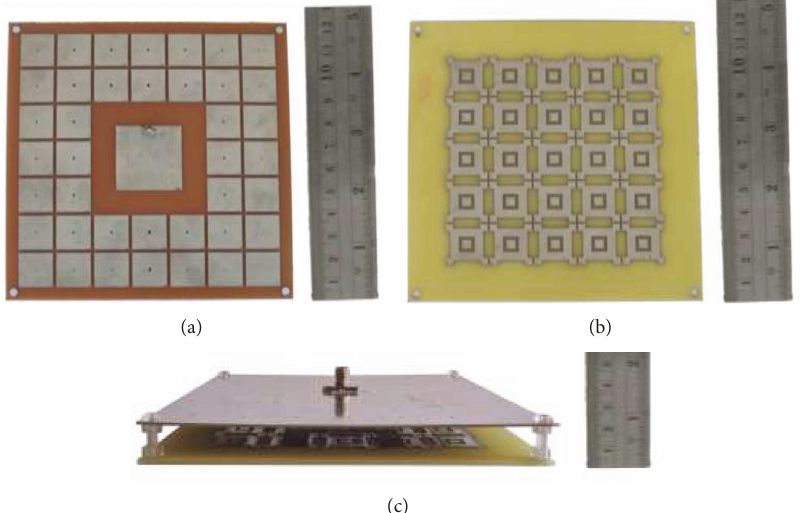
Figure 13: Photograph images of (a) the prototype microstrip antenna with HIS, (b) the prototype-modi fi ed FSS superstrate layer, and (c) the side view of the HIS-FSS integrated microstrip antenna.